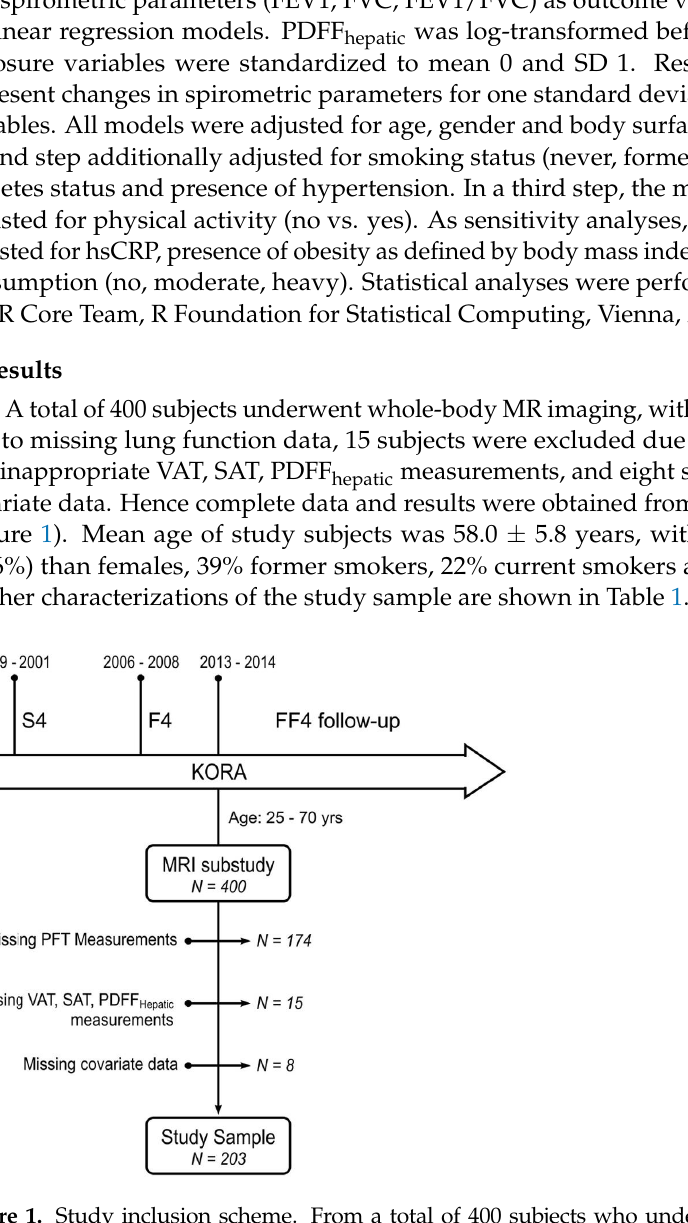
Figure 1. Study inclusion scheme. From a total of 400 subjects who underwent whole-body MRI, 197 subjects had to be excluded due to missing pulmonary function test measurements, missing VAT, SAT, PDFF hepatic measurements, and missing covariate data. VAT = visceral adipose tissue; SAT = subcutaneous adipose tissue; PDFF = proton density fat fraction; PFT = pulmonary function test.